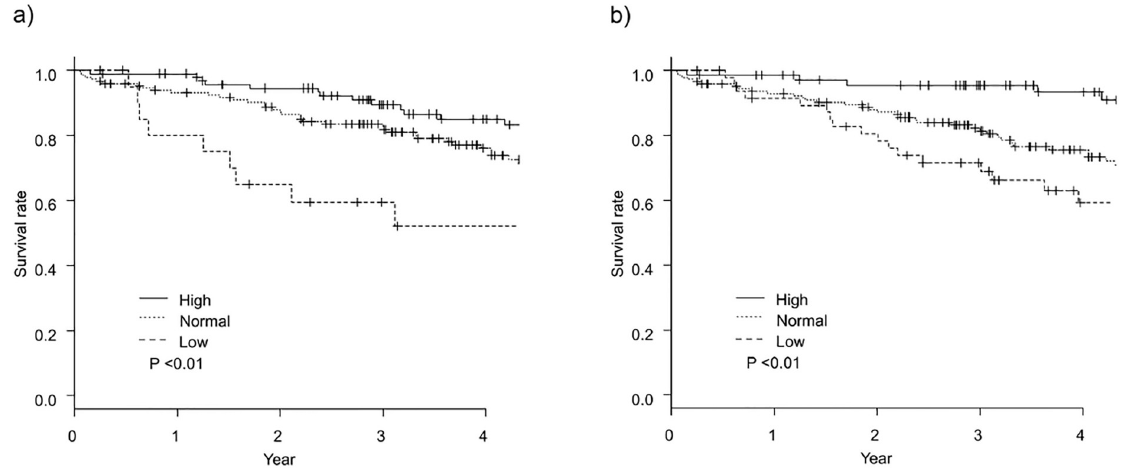
Fig 1. Kaplan–Meier survival curve analyses of event-free survival, based on the BMI category. a) The first HD session. b) Two weeks after HD initiation. Abbreviations; BMI; body mass index, HD;